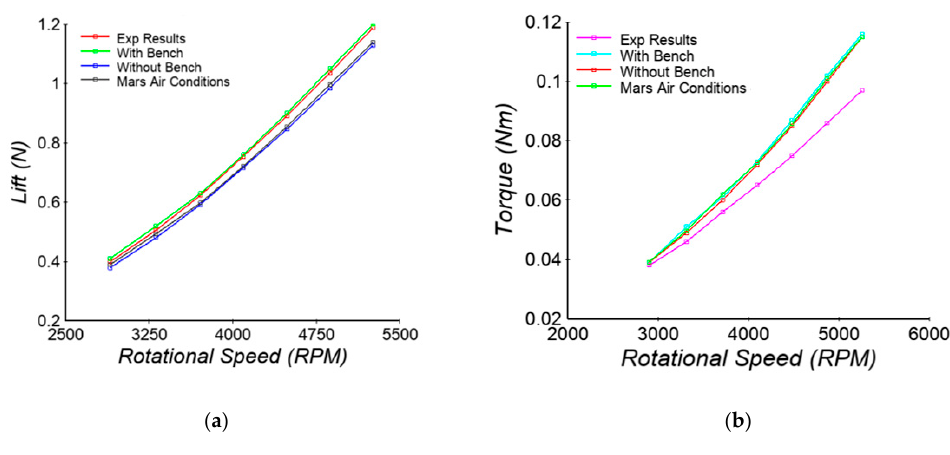
Figure 4. Calculation results of lift ( a ) and torque ( b ).